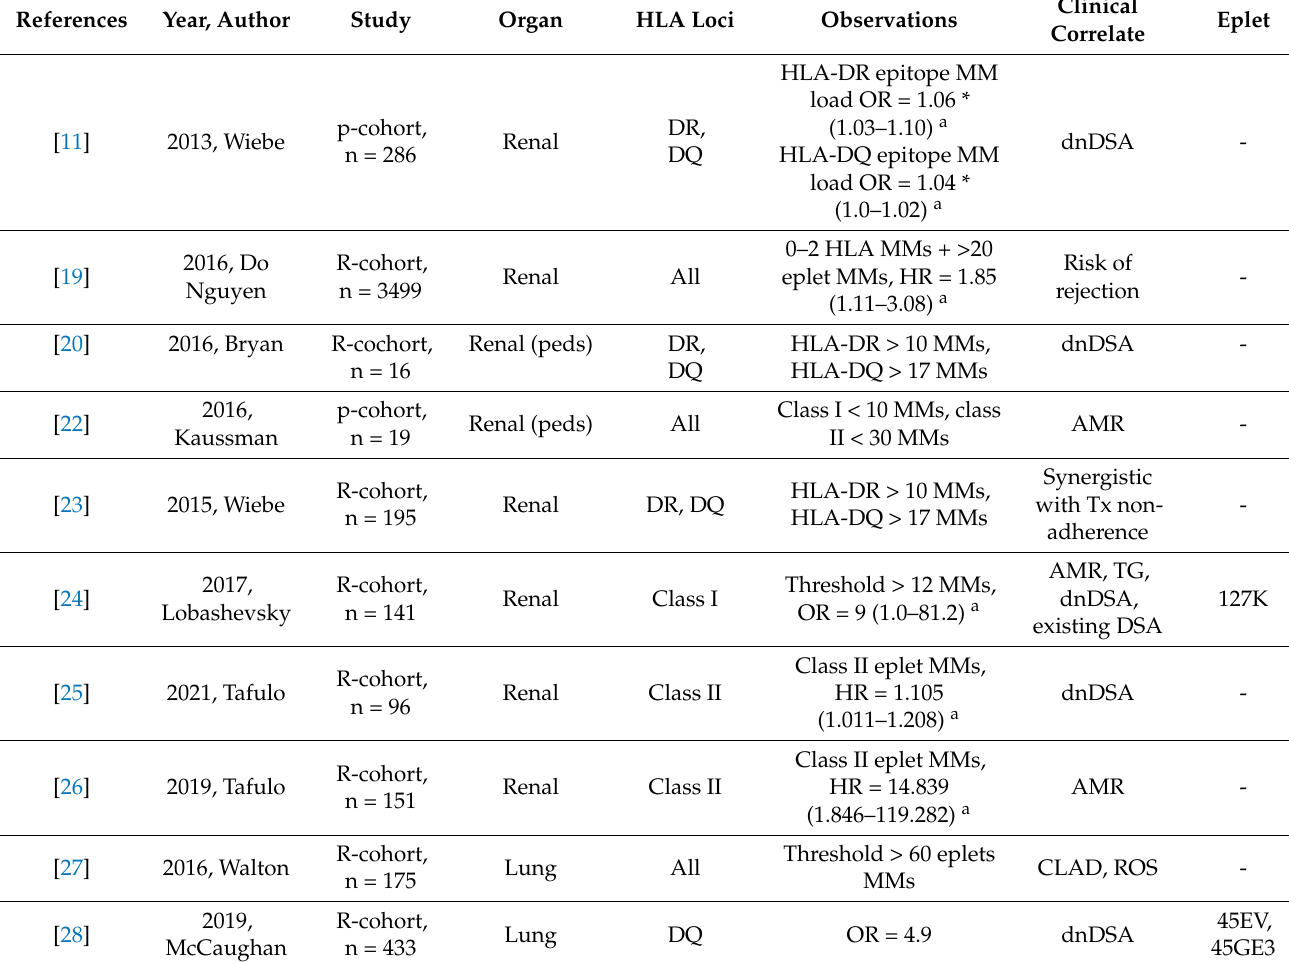
Table 1. Selected studies and corresponding results of eplet mismatch in solid organ